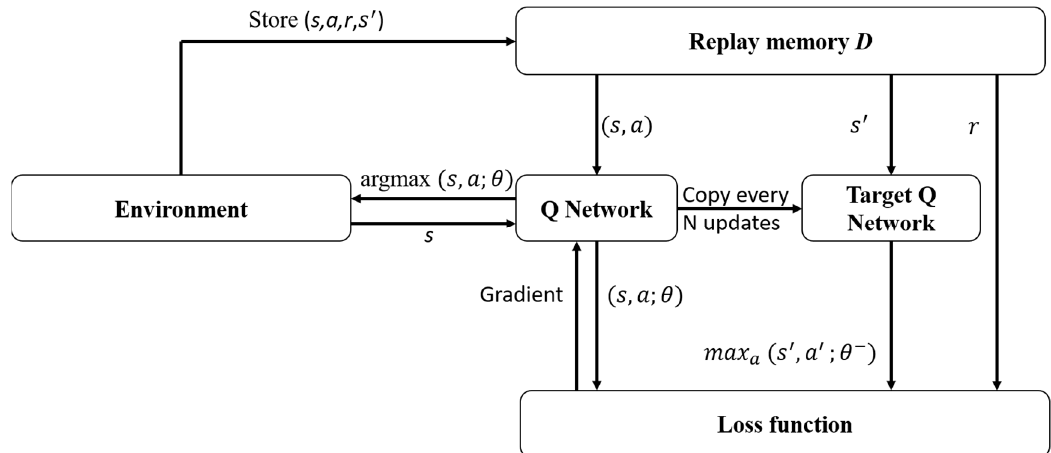
Figure 19. The DQN algorithm diagram.